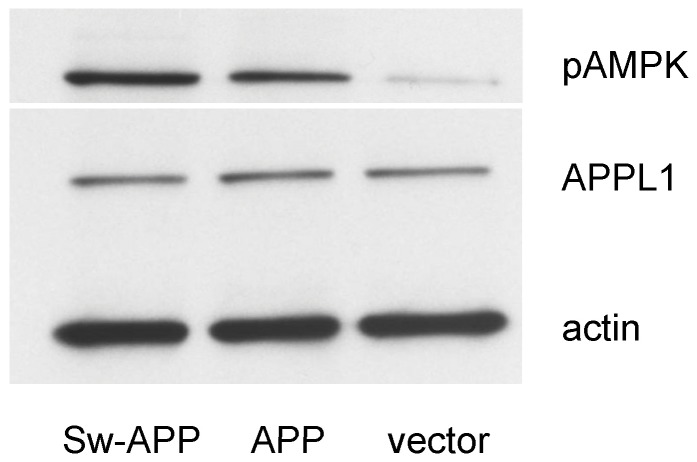
Western blot analysis of cell lysates for phosphorylated AMP-activated protein kinase (pAMPK) and the endosomal adaptor protein APPL-1 (adaptor protein with phosphotyrosine binding, pleckstrin homology domains and leucine zipper motif).Immunoblotting demonstrated that SH-SY5Y cells transfected with Sw-APP mutant (Sw-APP) had increased pAMPK than SH-SY5Y cells transfected with wt-APP (APP) which had increased pAMPK than control cells transfected with empty-vector (vector). Expression of APPL1 was indifferent among the three groups of cells. Experiments were repeated 3 times with consistent results.